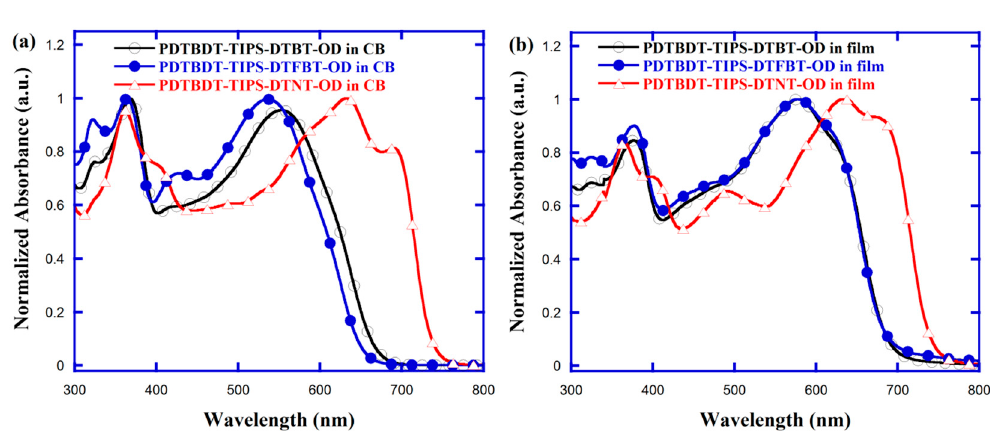
Figure 2. Normalized UV-vis absorption spectra of copolymers in diluted chlorobenzene (CB) solution of approximately 10 − 5 mol L − 1 ( a ) and thin film state ( b ).